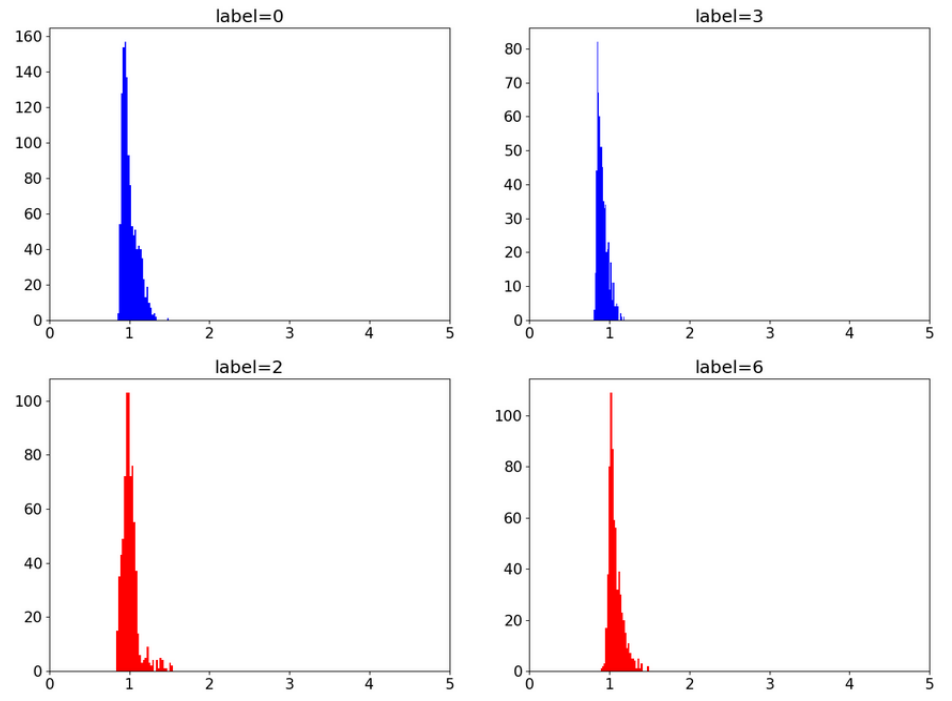
Figure 6. Rotation task: Transfer-relevant (outlier) target instance histograms are depicted in red (blue). The figure is best viewed in